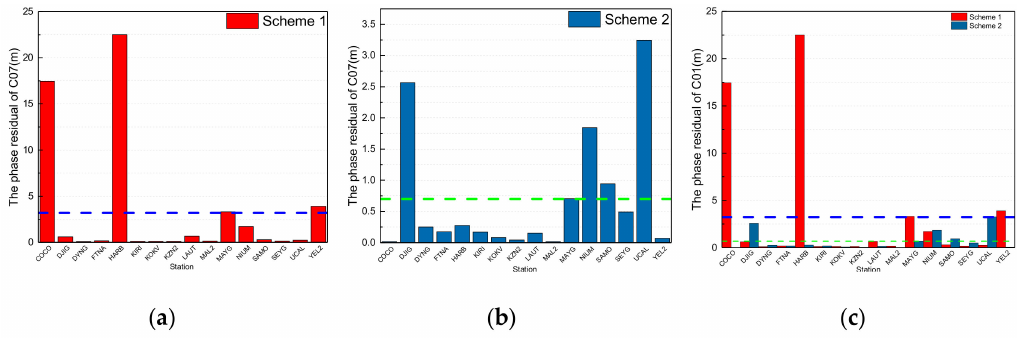
Figure 4. Phase residuals of stations for C07 in the first adjustment for data processing on October 16, 2017: residuals from precise orbit determination according to ( a ) scheme 1 and ( b ) scheme 2 and ( c ) comparison between Figure